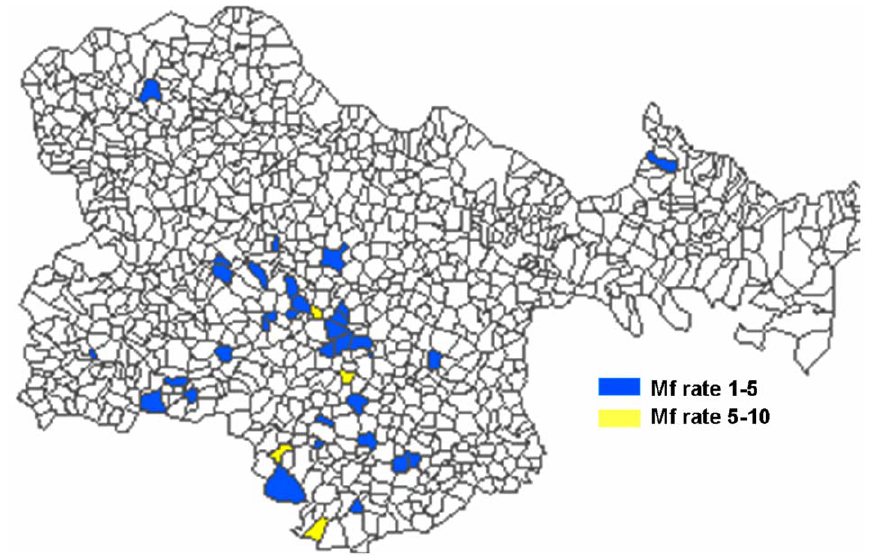
Figure 1. Distribution of microfilaremia prevalence in villages of Karimnagar district of Andhra Pradesh, India.